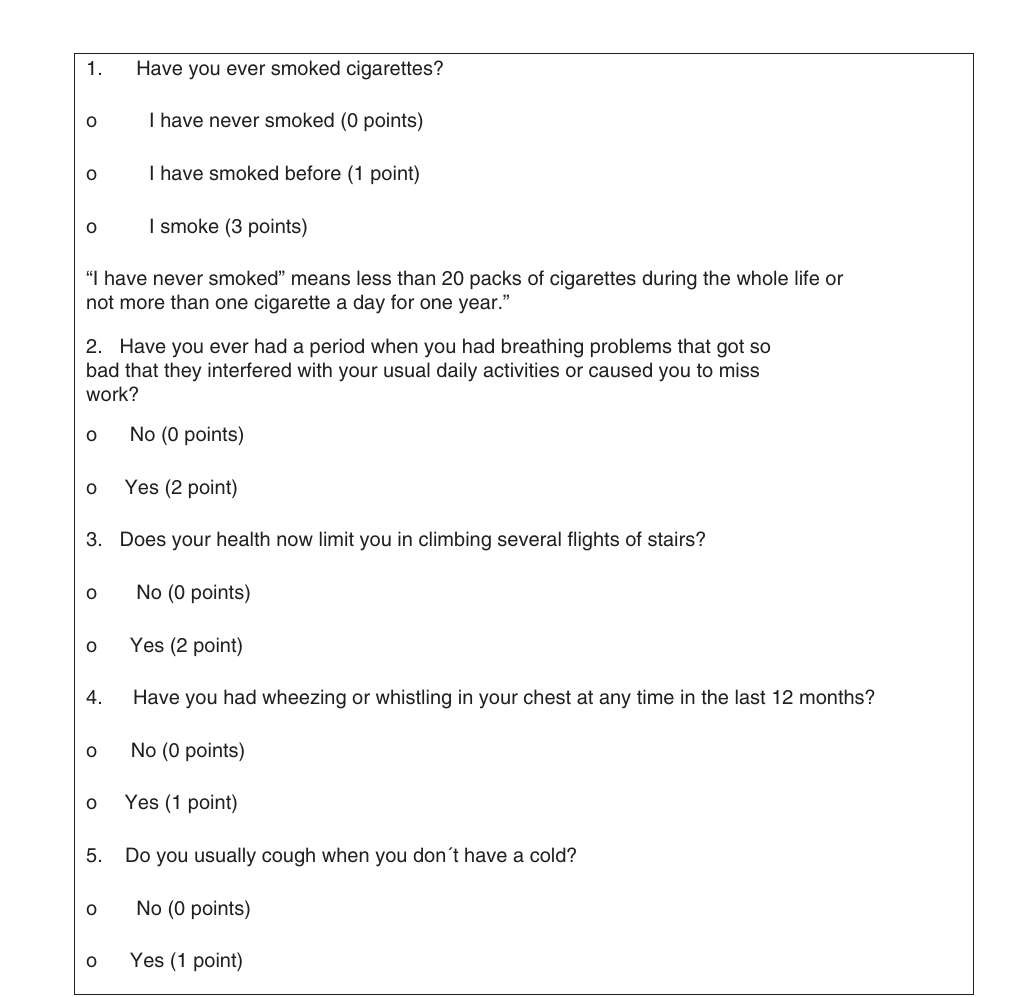
Fig. 1 Items of the Salzburg COPD – screening questionnaire